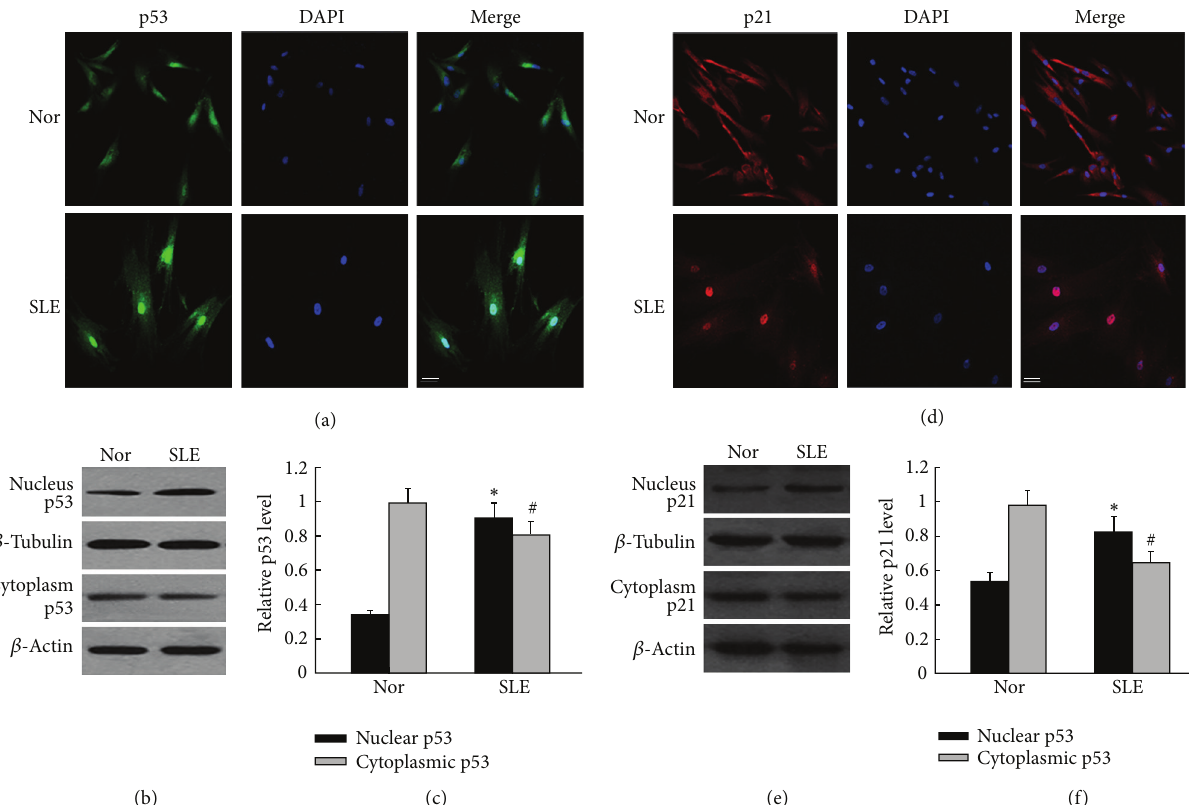
Figure 3: Analysis of the location and expression of p53 and p21 in the cytoplasmic and nuclear of BM-MSCs from SLE patients. ((a), (d)) Immunofluorescence staining to analyze the location of p53 and p21 in BM-MSCs. In the BM-MSCs from SLE patients, there was a clear increase in nuclears p53 and p21 expression. The scale bar is 25mm. ((b), (e)) Western blot analysis of the cytoplasmic and nuclear p53 and p21 expressions. 𝛽 -Actin was used as the internal control for the cytoplasmic proteins, whereas 𝛽 -tubulin was used as the internal control for the nuclear proteins. ((c), (f)) Quantification the expressions of p53 and p21 in the nuclear and cytoplasmic. Compared with normal control, the location and expression of p53 and p21 in the nuclear of BM-MSCs were significantly higher in SLE patients. The relative levels of protein expressions were normalized to 𝛽 -actin expression. Values are means ± SD of three experiments ( ∗ 𝑃 < 0.05